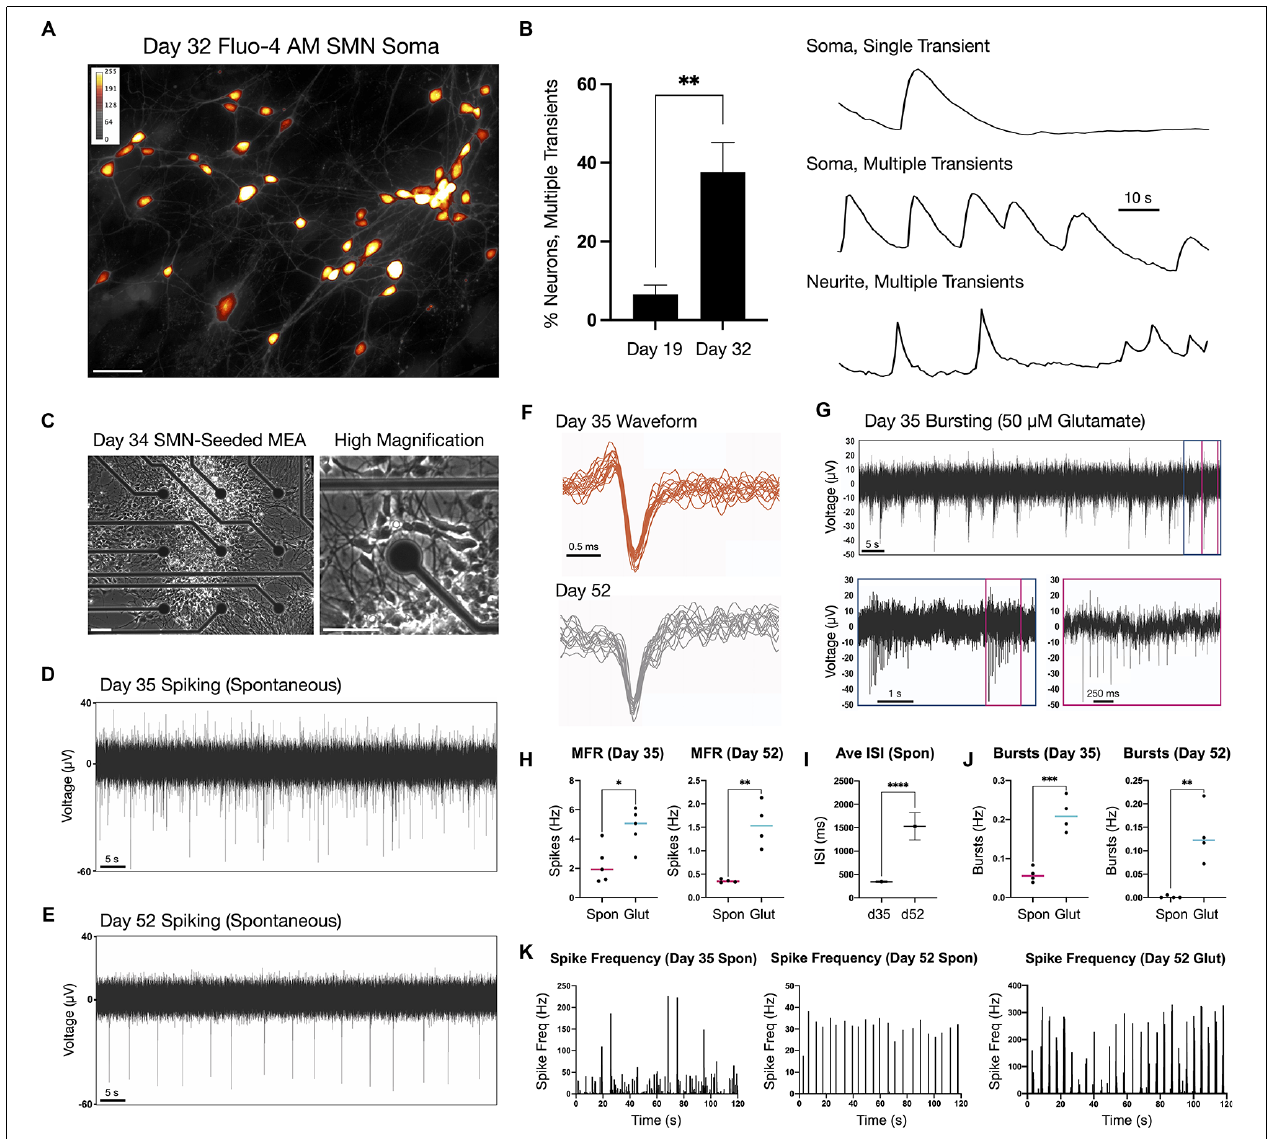
FIGURE 3 | Firing properties of adherent spinal neurons by calcium imaging and microelectrode arrays (MEA) at two time points. (A) Calcium dye Fluo-4 AM somatic signal in adherent SMNs (day 32). ImageJ Smart LUT fluorescence intensity (yellow high, gray low). (B) Left: Proportion of SMNs exhibiting multiple calcium transients above threshold in the 1.5 min recording window at day 19 (6.6 ± 2.3%, n = 83 neurons, N = 5 repeat experiments) and day 32 (37.6 ± 7.5%; n = 101 neurons, N = 5 repeat experiments). ** P = 0.0043. Right: Representative examples of single and multiple transients in soma and neurite of day 32 SMNs over the 1.5 min recording window (F/Fo). Scale bar is 10 s. (C) Phase contrast images of SMN-seeded MEAs at day 34 in differentiation (seeded day 28). (D,E) Representative traces from single MEA channel depicting spontaneous SMN voltage spikes recorded at day 35 (D) and day 52 (E) in differentiation. (F) Representative overlay of spontaneous spike waveforms at day 35 and day 52 from traces in (D,E) . (G) Representative single electrode bursting in day 35 cultures stimulated with 50 µ M glutamate. Three time scales are shown. Pink box depicts spikes within a single burst. (H) Quantification of mean firing rate (MFR, Hz) in day 35 and day 52 cultures. Spontaneous firing is compared to 50 µ M glutamate stimulation (two-tailed t test; day 32 t = 3.096, df = 8, ∗ P = 0.0148; day 52 t = 4.968, df = 6, ∗∗ P = 0.0025). (I) Average inter-spike interval (ISI) in day 35 vs. day 52 SMNs under spontaneous conditions ( t = 10.52, df = 499, ∗∗∗∗ P < 0.0001). (J) Single electrode burst rate (Hz) in day 35 vs. day 52 SMNs (day 32 t = 6.426, df = 6, ∗∗∗ P = 0.0007; day 52 t = 4.356, df = 6, ∗∗ P = 0.0048). (K) Spike frequency (Hz) vs. time (s) in day 35 vs. day 52 SMNs. Also shown is spike frequency for day 52 SMNs stimulated with 50 µ M glutamate is shown (rightmost plot). Spontaneous (spon), glutamate (glut). Scale bars are 50 µ